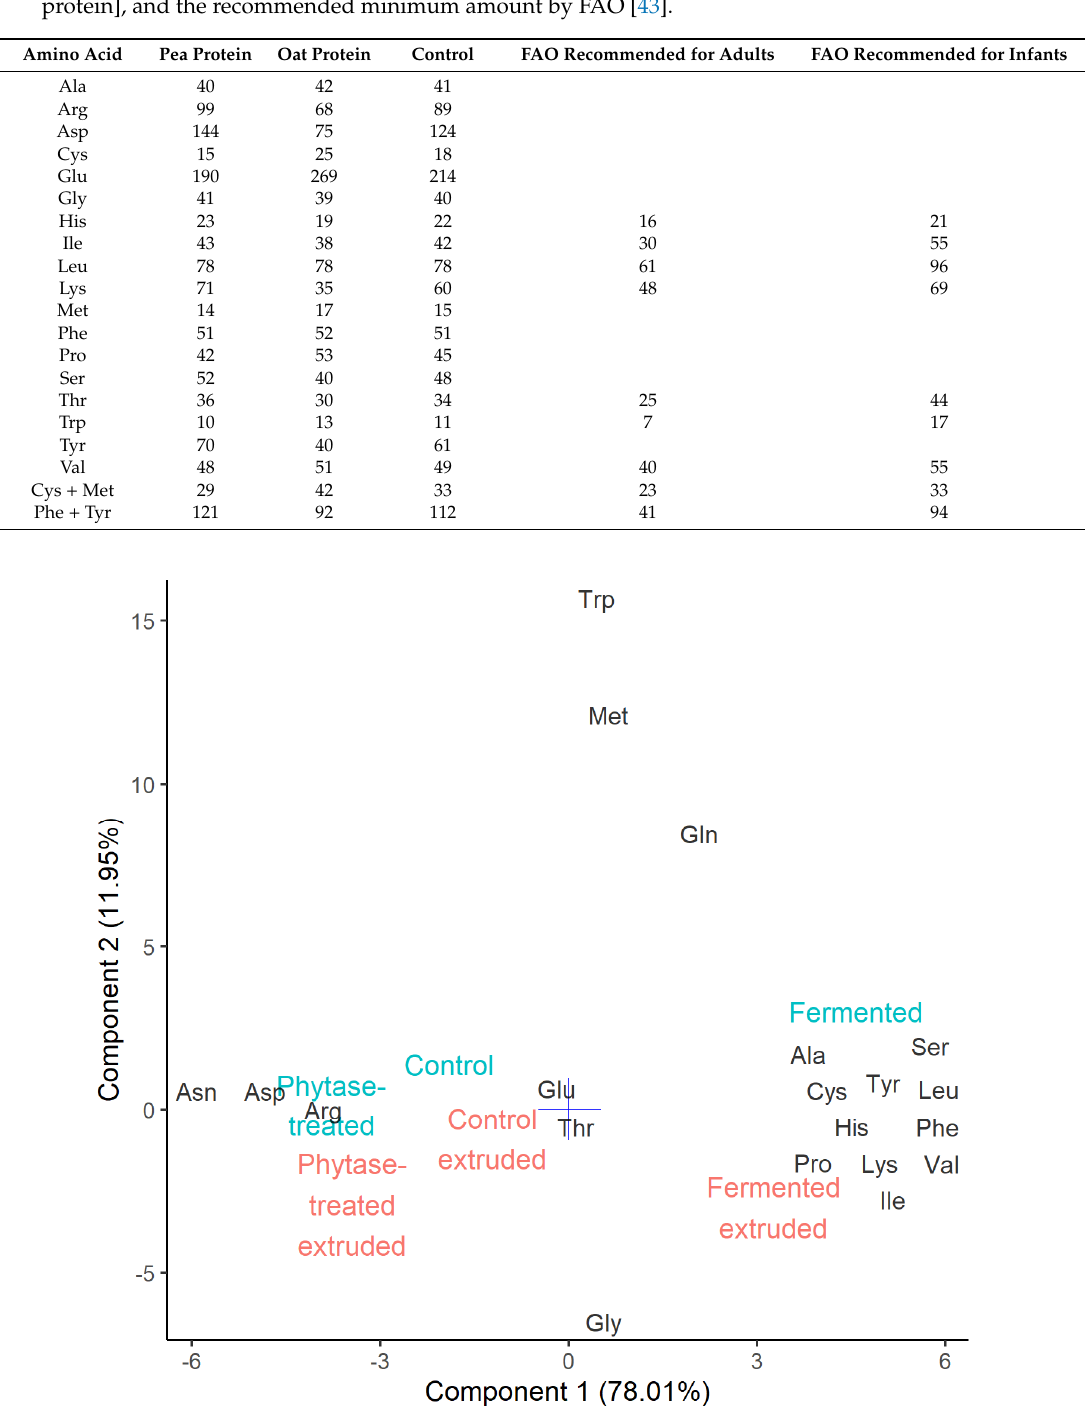
Figure 4. Sparse principal component analysis of free amino acid content of powders (blue) and extrudates (red). The number in parenthesis indicates variance captured by the principal component.